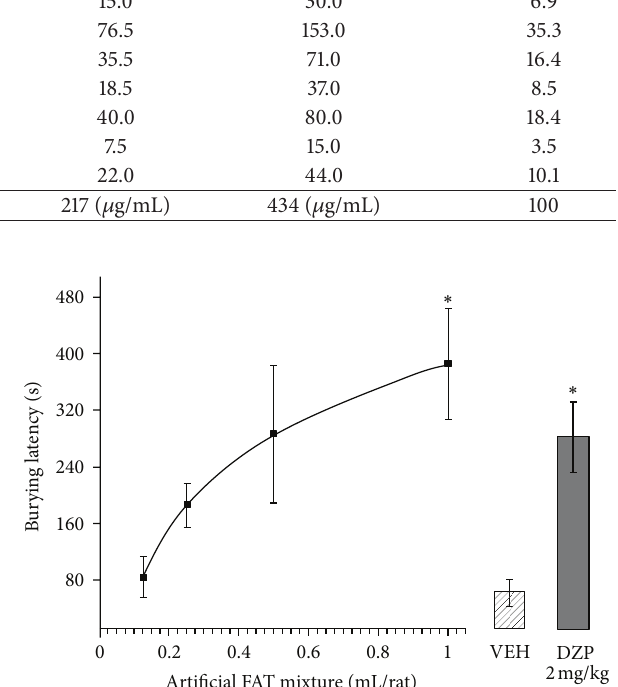
Figure 1: Burying latency. A volume of 1mL of the artificial FAT mixture and diazepam (2.0 mg/kg) significantly ( ∗ 𝑃 < 0.002 , SNK post hoc test) increased burying latency compared with vehicle and the 0.125 and 0.25 mL artificial FAT mixture groups. The data points of the dose-response curve were fit to a logarithmic curve (𝑅 = 0.965) . FAT, fatty acid; VEH, vehicle of fatty acid mixture; DZP,